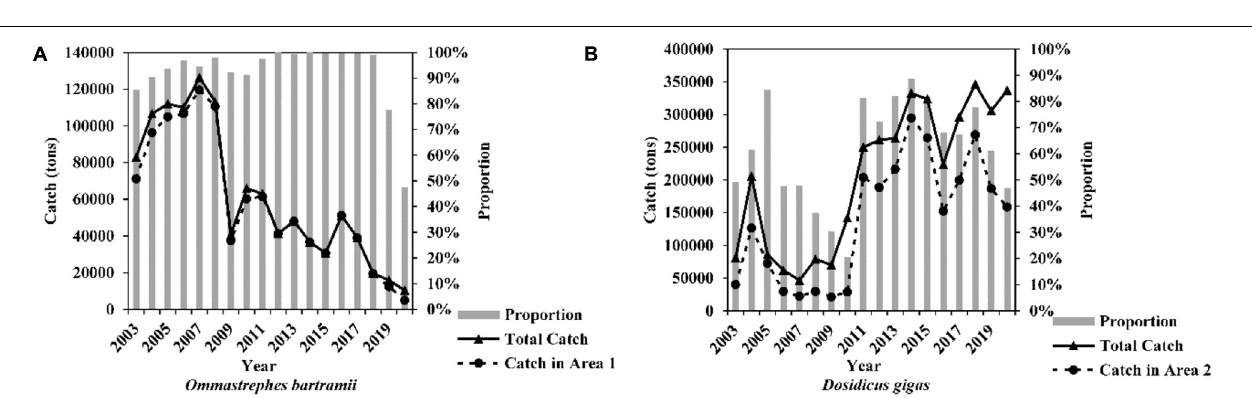
FIGURE 1 | Spawning and feeding grounds (also fishing grounds) of Ommastrephes bartramii (stock of the winter-spring cohort) and Dosidicus gigas (off Peru Exclusive Economic Zone, PEEZ). S1 and S2: the spawning ground of O. bartramii ; Area 1: the feeding ground (also the main fishing ground) of O. bartramii ; S3: the spawning ground of D. gigas ; Area 2: the feeding ground (also the main fishing ground) of D. gigas . Latitude and longitude points for drawing the boundary of S1, S2, S3, Area 1, and Area 2 are presented in Supplementary Table 1 .